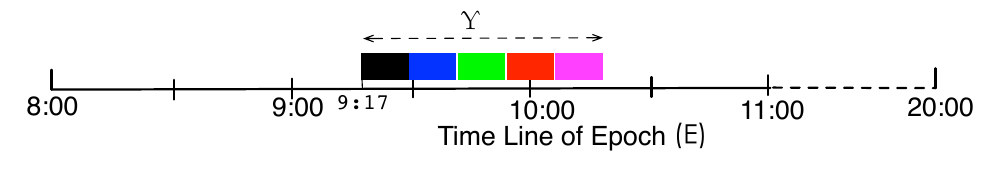
Figure 2. An example of data gathering schedule within an epoch.